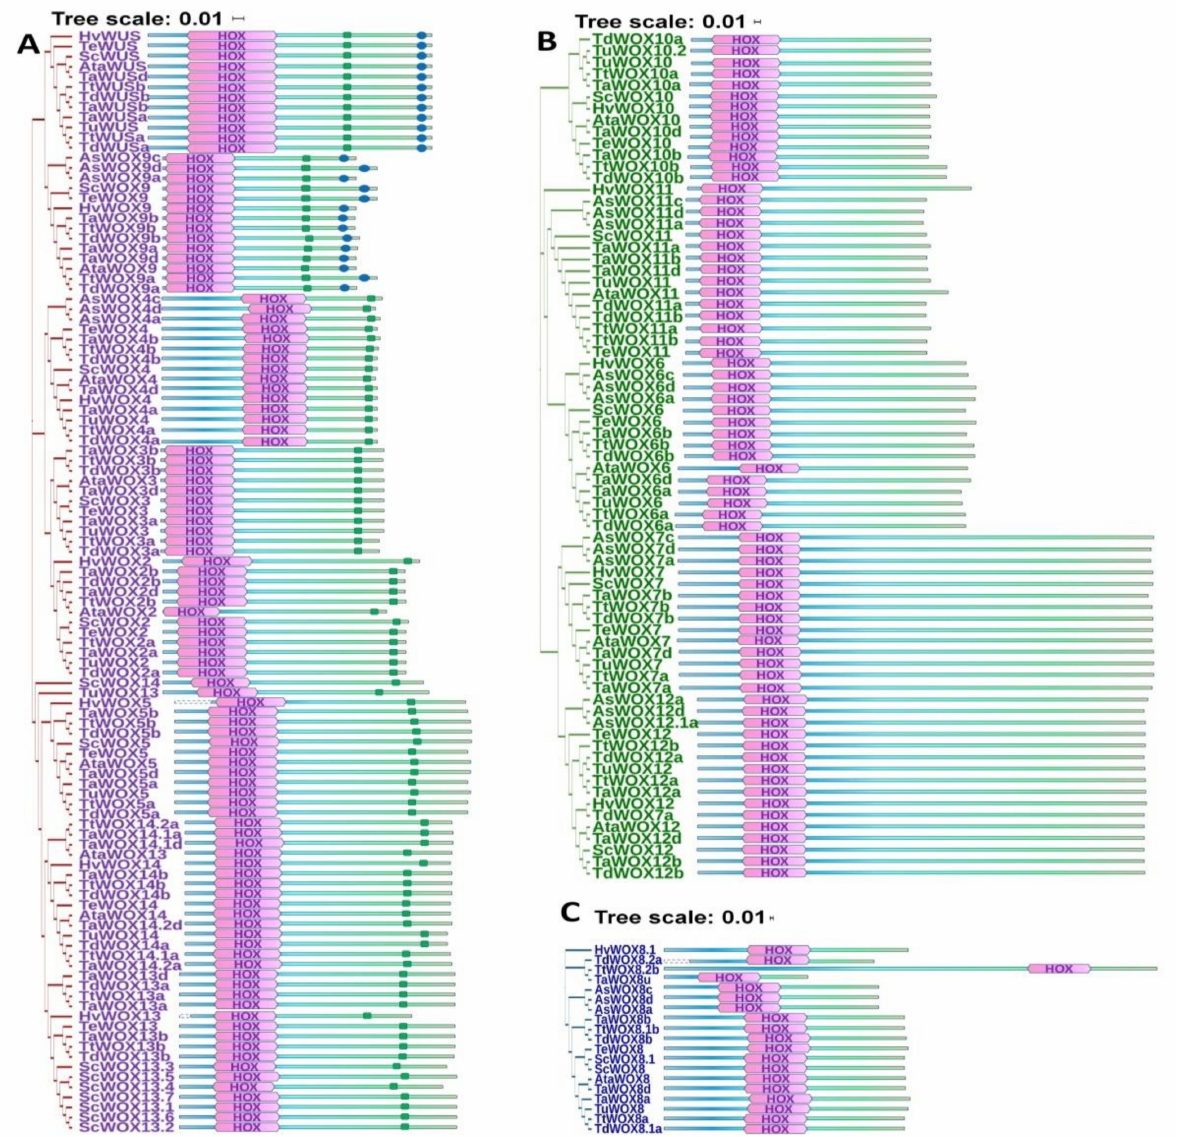
Figure 6. Depiction of the domain structure of WOX proteins in nine Triticeae species. Positions of HOX homeodomain, WUS-Box motif and EAR domain in WOX protein of nine Triticeae species including T. aestivum , H. vulgare , T. elongatum, A. sativa , S. cereale , T. dicoccoides, T. turgidum, A. tauschii , and T. urartu . WOX members were divided by their phylogenetic relationship. There were HOX homeodomain, WUS-Box motif and EAR domain in WUS clade WOX proteins in these nine Triticeae species ( A ). Positions of HOX homeodomain in intermediate clade WOX proteins in these nine Triticeae species ( B ). Positions of HOX homeodomain in ancient clade WOX proteins in these nine Triticeae species ( C ). Length of WOX members were displayed by the bar length, positions of HOX homeodomain were displayed as pink hexagon, WUS-Box motif was displayed as green round dot, and EAR domain was displayed as blue round